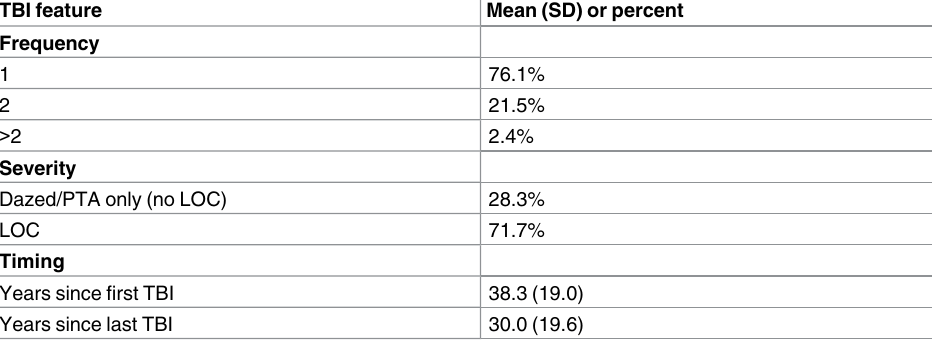
were unchanged in sensitivity analyses stratified by TBI severity (Table 4).